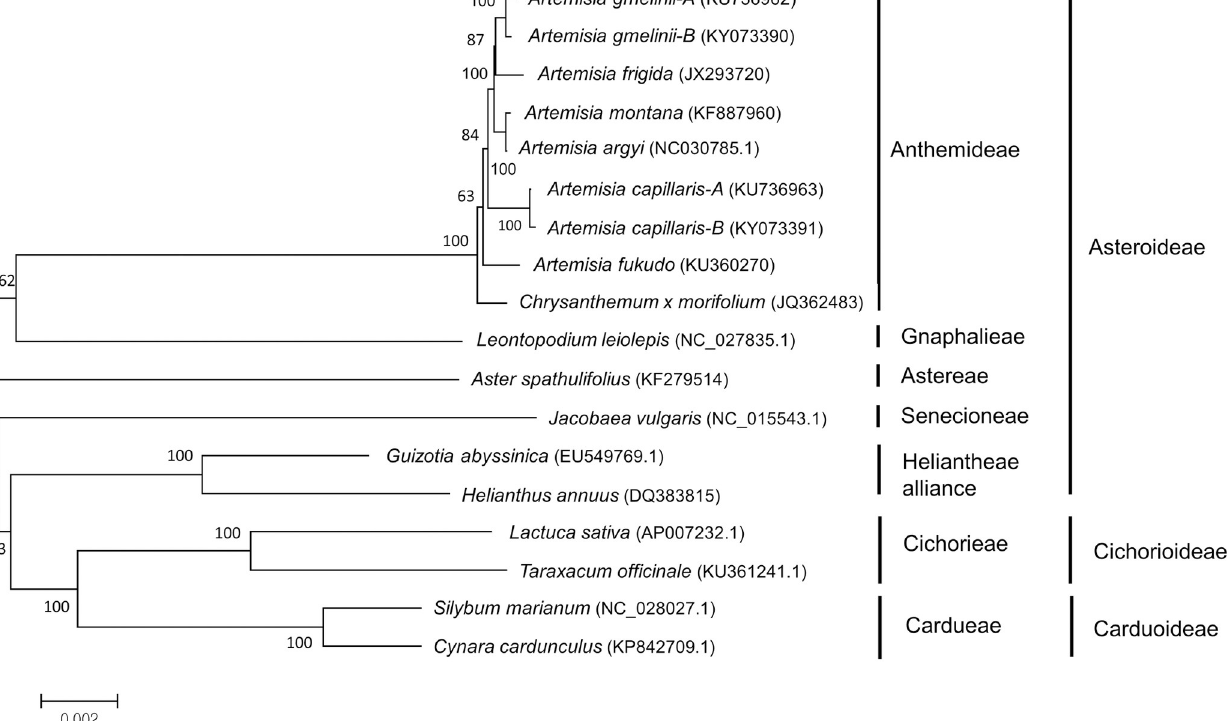
Fig 2. A phylogenetic tree of 18 species belonging to the Asteraceae family. A total of 64 coding regions in the chloroplast genome were used to analyze phylogenetic relationships among the species. The phylogenetic tree was constructed by the neighbor-joining method with 1000 bootstrap values. Numbers on each node were bootstrap values. The accession number of the chloroplast genomes used for the phylogenetic tree are in parenthesis and S2